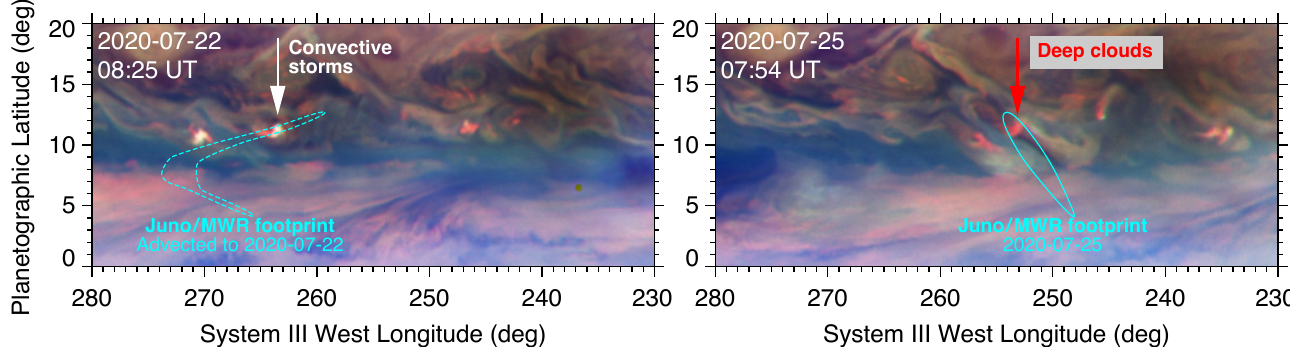
Figure 3. HST observations indicate deep clouds in areas sampled by Juno/MWR ( right ), but Juno did not detect lightning associated with these clouds. HST imaging three days prior ( left ) suggests an earlier moist convective eruption that may have generated lightning activity, but the storm evolved within three days, losing the tall thick cloud towers characteristic of active convection by the time Juno flew over the area. The Juno/MWR footprint envelope on 2020-07-22 is distorted to account for advection by the zonal mean flow over the three-day interval between the HST imaging data and the Juno pass (using the 2020 zonal wind profile from OPAL program data [68]).